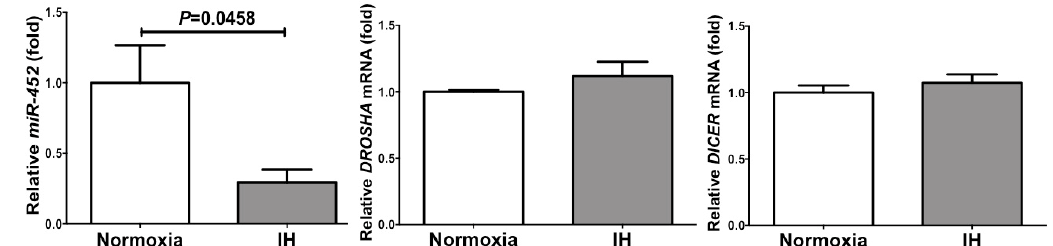
Figure 6. The levels of miR-452 , DROSHA mRNA, and DICER mRNA of SW872 cells treated with normoxia or IH for 24 h. The levels of miR-452 and DROSHA and DICER mRNAs were measured by real-time RT-PCR using U6 (for miR-452) and β -actin (for DROSH and DICER ) as an endogenous control. Data are expressed as mean ± SE for each group ( n = 4–6). The statistical analyses were performed using Student’s t -test.